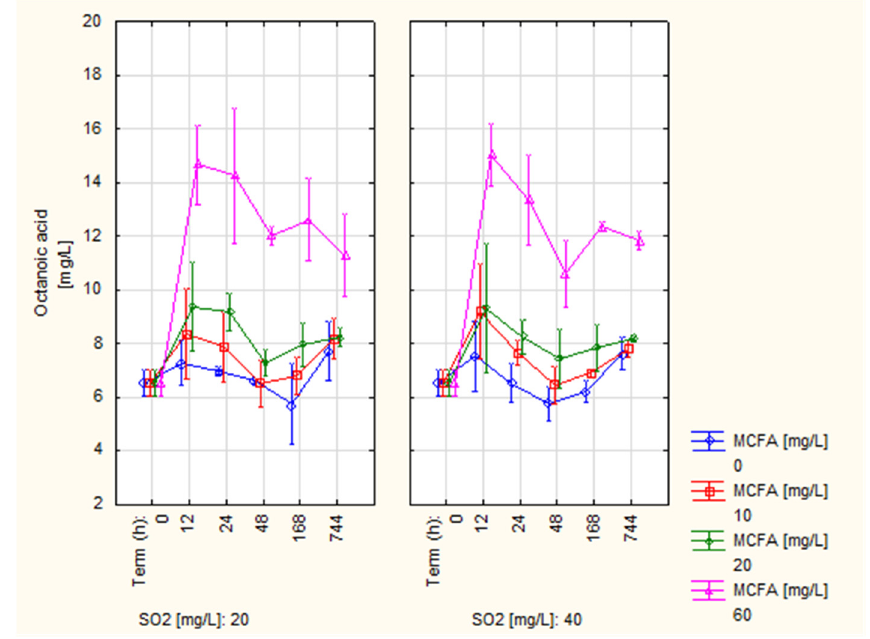
Figure 1. Development of octanoic acid content